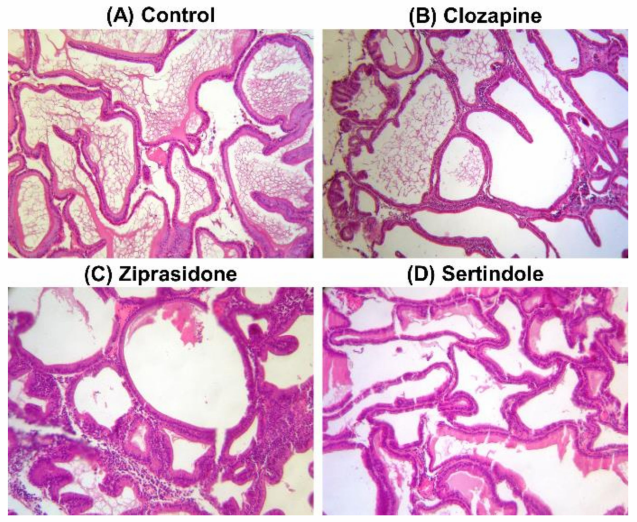
Figure 3. Photomicrographs of rat prostate tissue structure, H&E stain, 200 × . Control group–( A ); Clozapine-treated group–( B ); Ziprasidone-treated group–( C ); Sertindole-treated group–( D